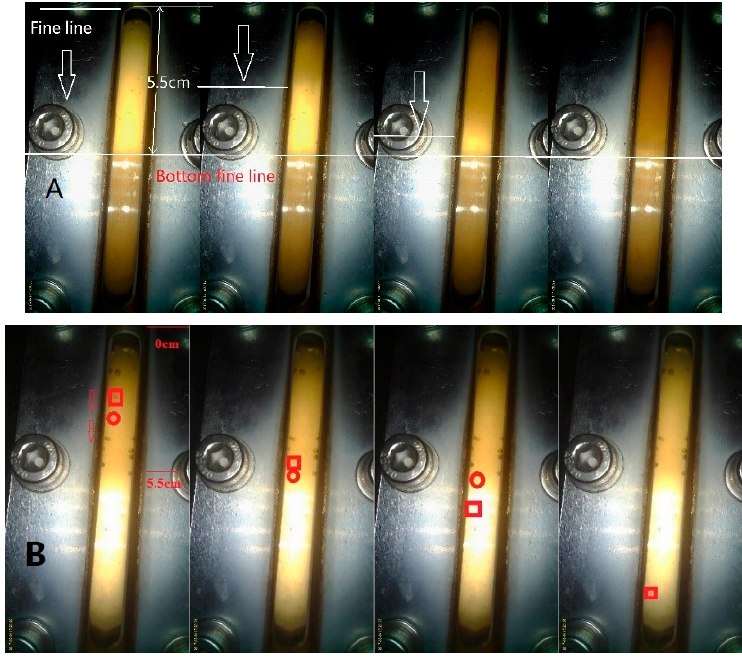
Figure 6. Sand production in the visual window ( A ) fine sand as a whole and ( B ) sand